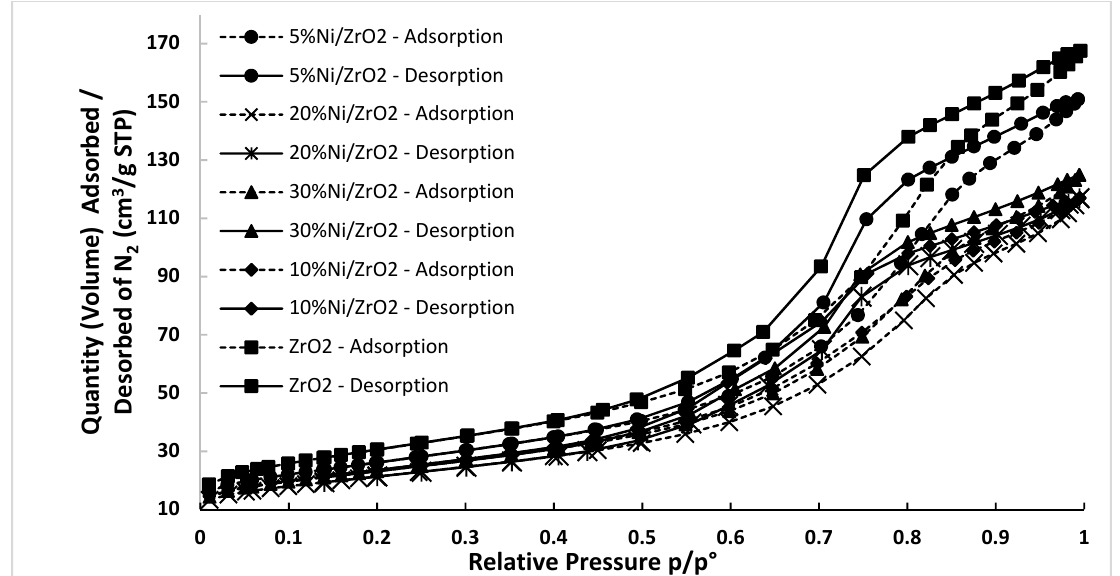
Figure 14. BET adsorption–desorption isotherms for supports and monometallic Ni catalysts calcined in an air atmosphere at 400 °C for 4h.